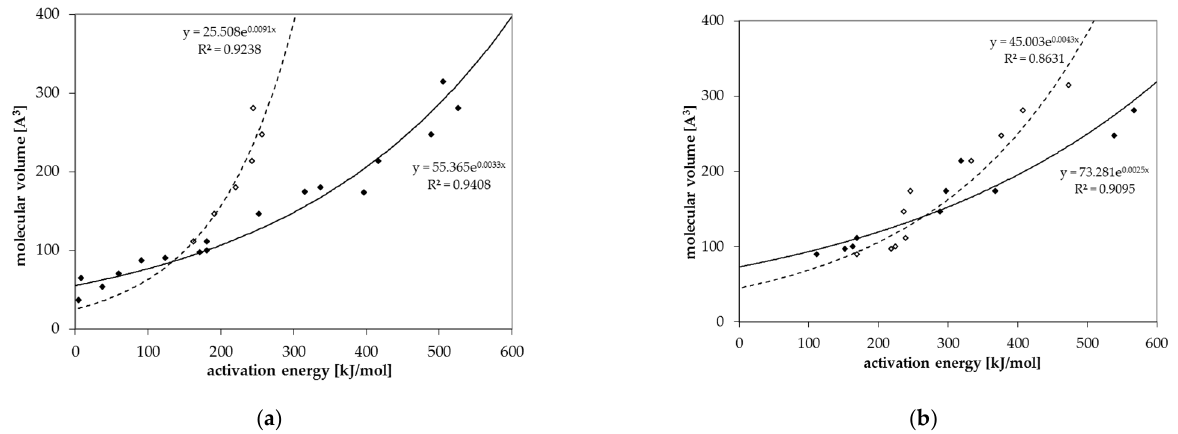
Figure 4. Correlation between the molecular volume V and the activation energy of diffusion E A for ( a ) GPPS and ( b ) HIPS below T g (solid dots) and above T g (non-solid dots).